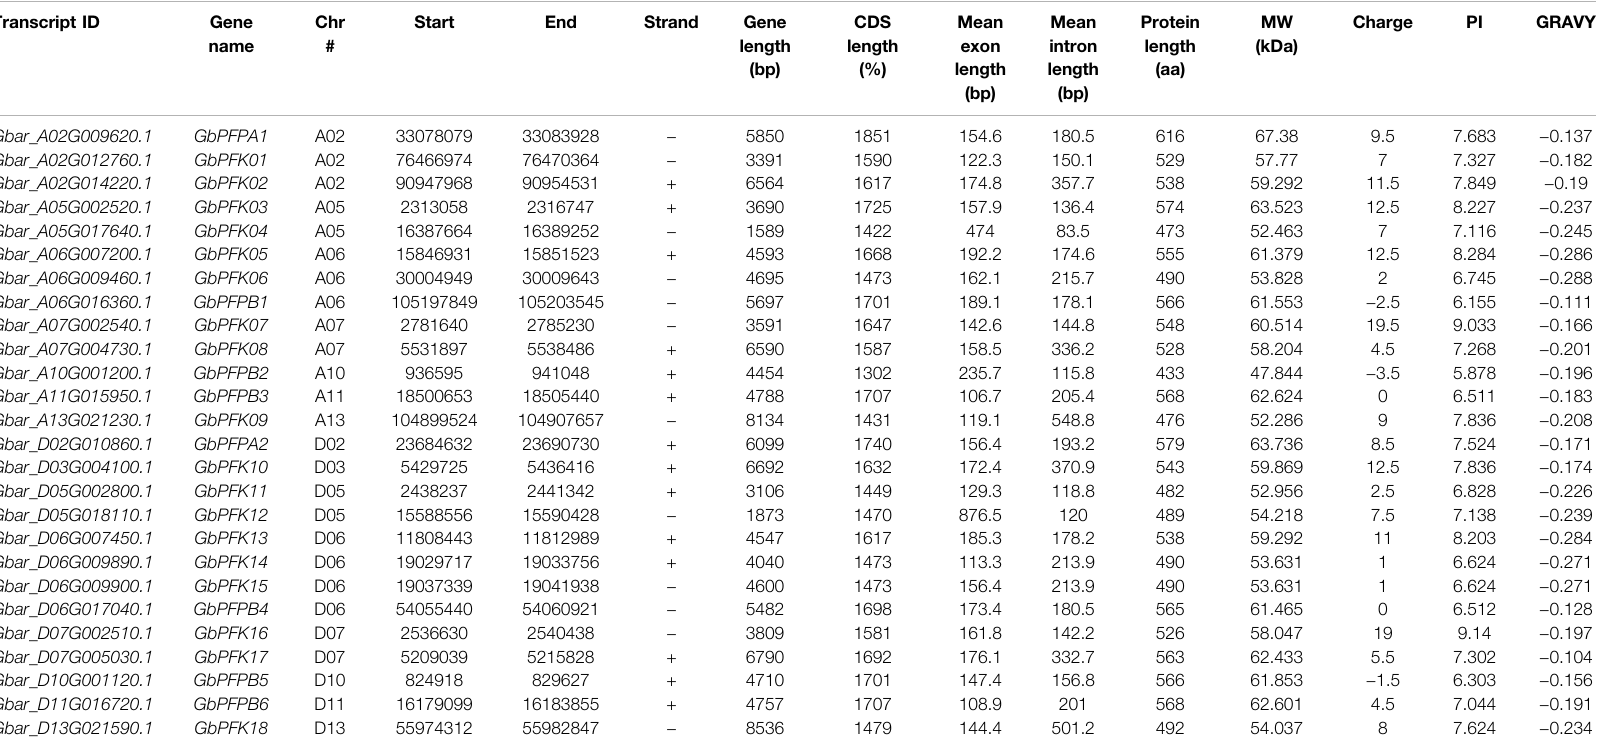
TABLE 4 | Transcript and physiochemical features of PFK genes in G. barbadense